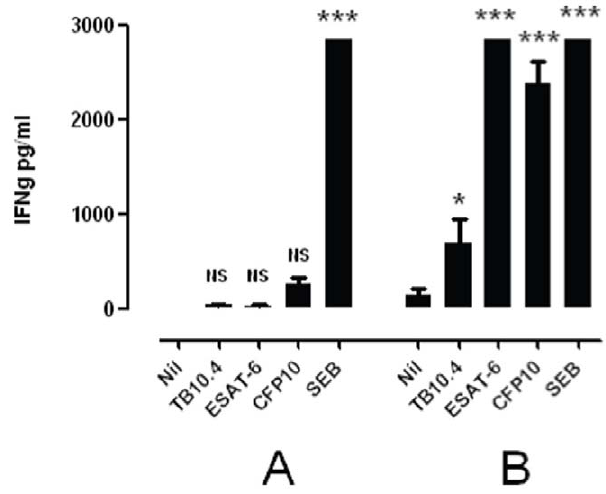
Figure 2. In vitro IFN c responses to selected antigens. PBMCs from two volunteers were tested for in vitro IFN c responses to selected M. tuberculosis antigens. A:volunteer from group C, TST negative, QFT-IT positive after 1. injection, but negative after 2. injection and at day 28. B: volunteer from group D, TST and QFT-IT positive after 1. injection and hereafter excluded. PBMCs were stimulated for five days with culture medium only (Nil), TB10.4 peptide mixture (TB10.4), ESAT-6 peptide mixture (ESAT-6), CFP10 peptide mixture (CFP10) or Staphylococcal